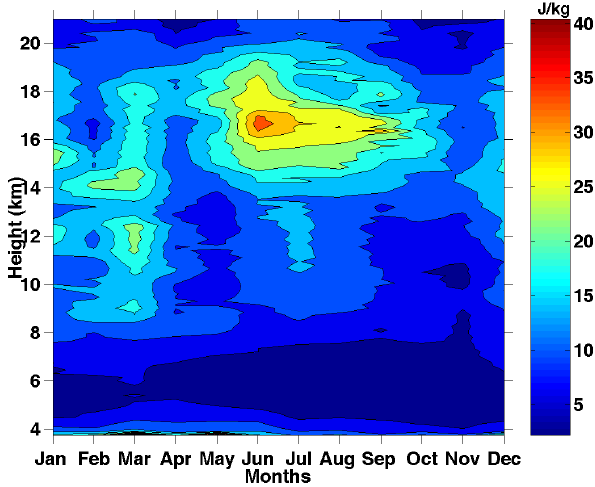
Fig. 4. A typical observed vertical wave number spectra of zonal and meridional kinetic energy for the month of March 2004.